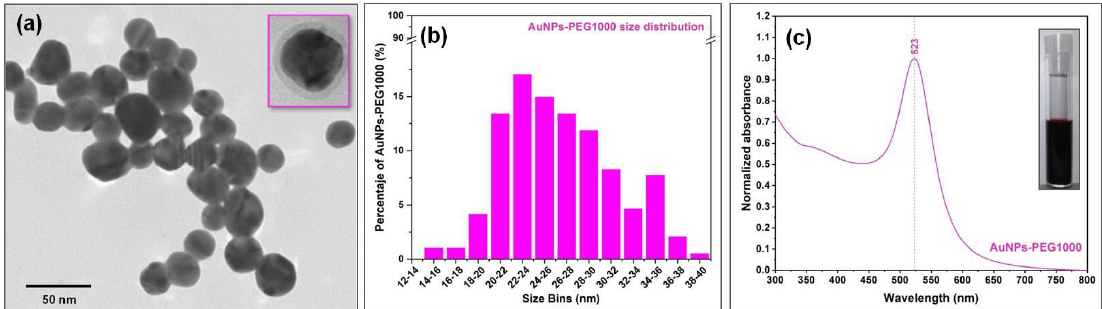
Figure 3. Transmission electron microscopy (TEM) image of PEGylated gold nanoparticles ( a ); TEM image of a single gold nanoparticle showing the presence of the polyethylene glycol (PEG) layer surrounding the nanoparticle (NP) (inset a). Statistical distribution of NPs sizes calculated from TEM images (b). UV-Vis absorption spectrum of the gold colloid ( c ); optical image of the gold colloid (inset